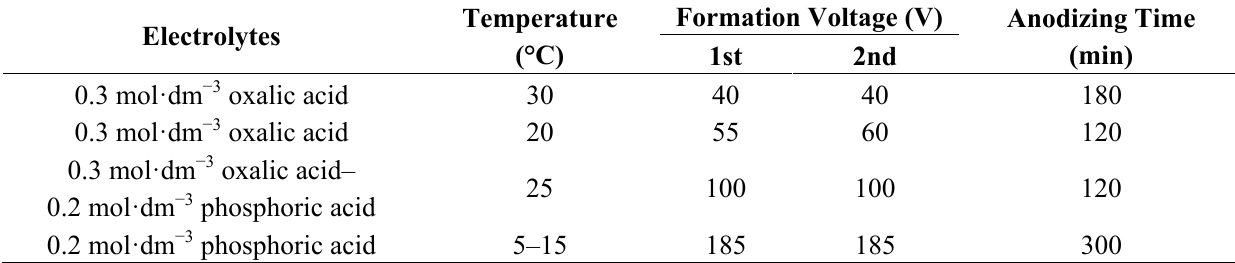
Figure 1. Current–time curves during the second anodizing step using the different voltages listed in Table 1. Table 1. Anodizing conditions employed for the fabrication of alumina membranes with different pore